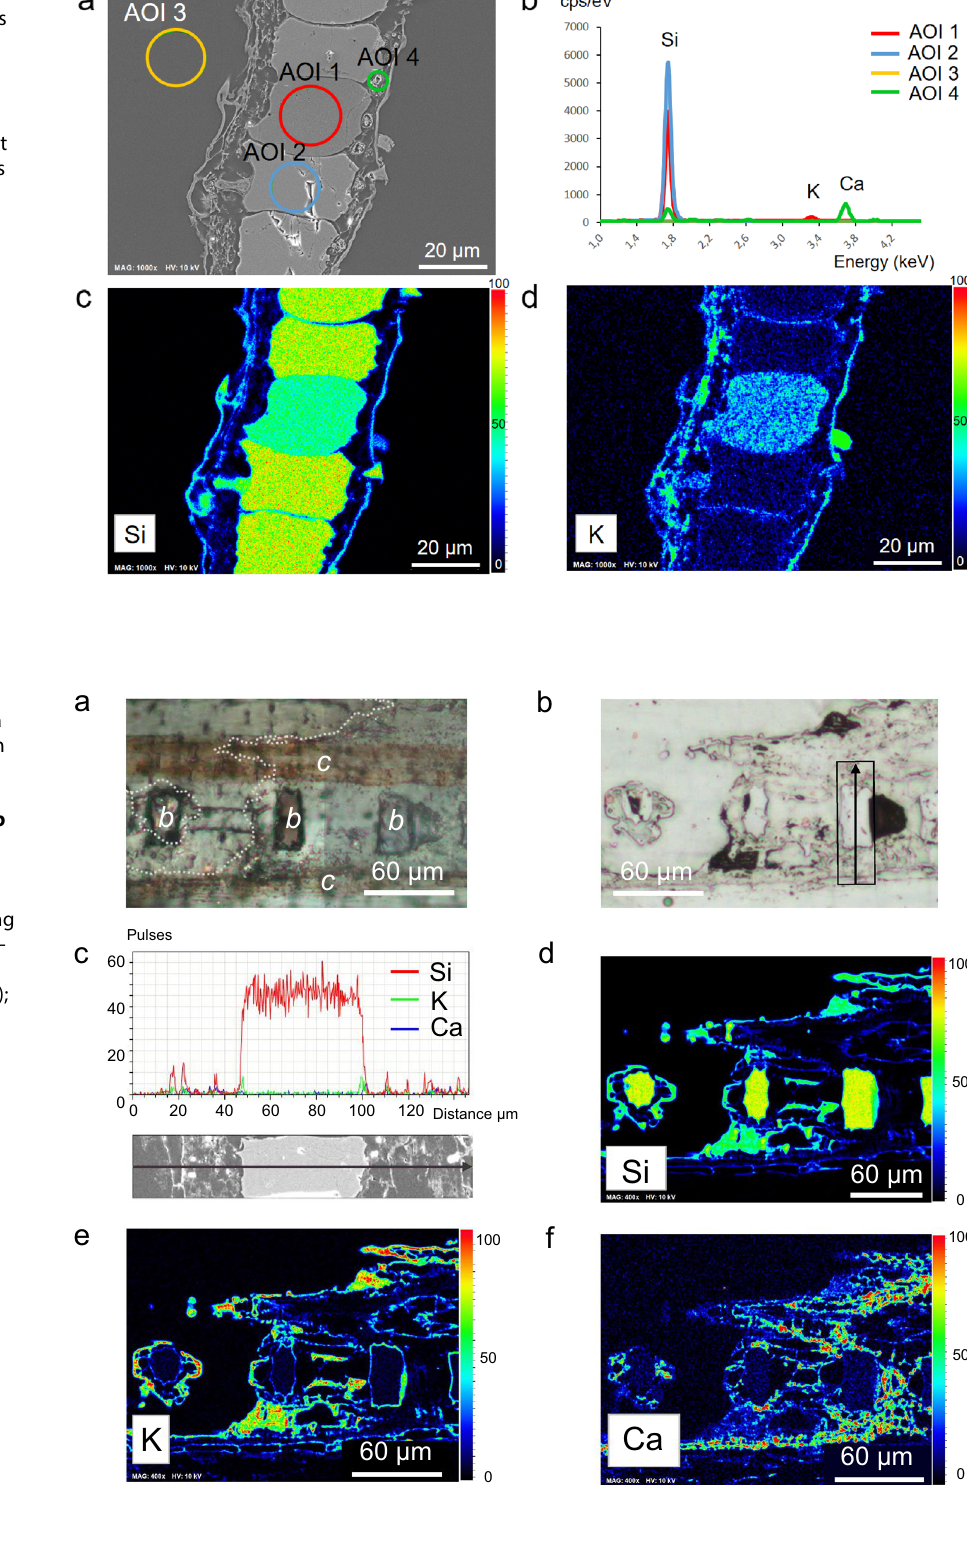
Fig. 4 Intercostal row of densely packed bulliform cells (Primavera-20). a SEM image with four demarcated AOIs (AOI 3 showing the back- ground); b EDS spectra in the AOIs with the most prominent peaks labeled for the minerals they represent; c EDS map of Si; d EDS map of K